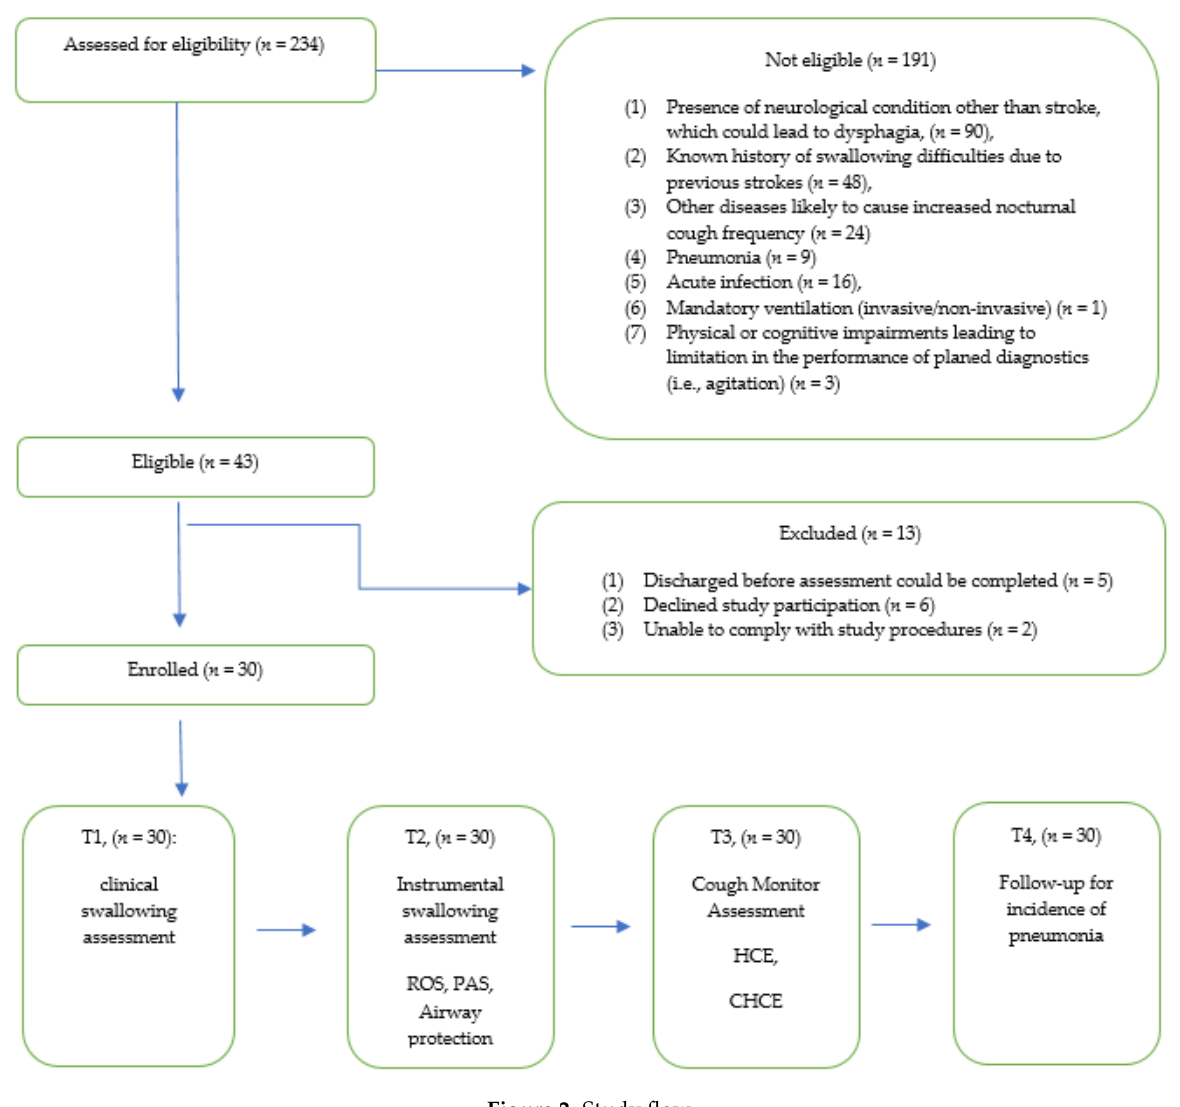
Figure 2. Study Figure 2. Study flow.